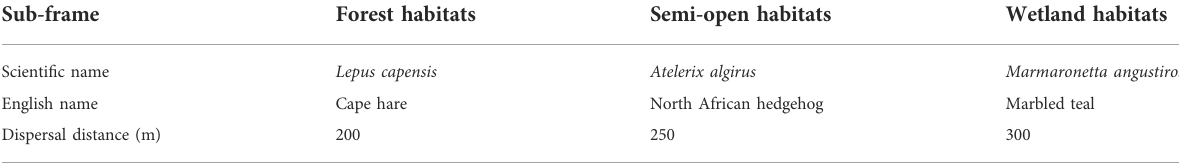
TABLE 5 Dispersal distances retained by sub-frame and species in the Sousse region.